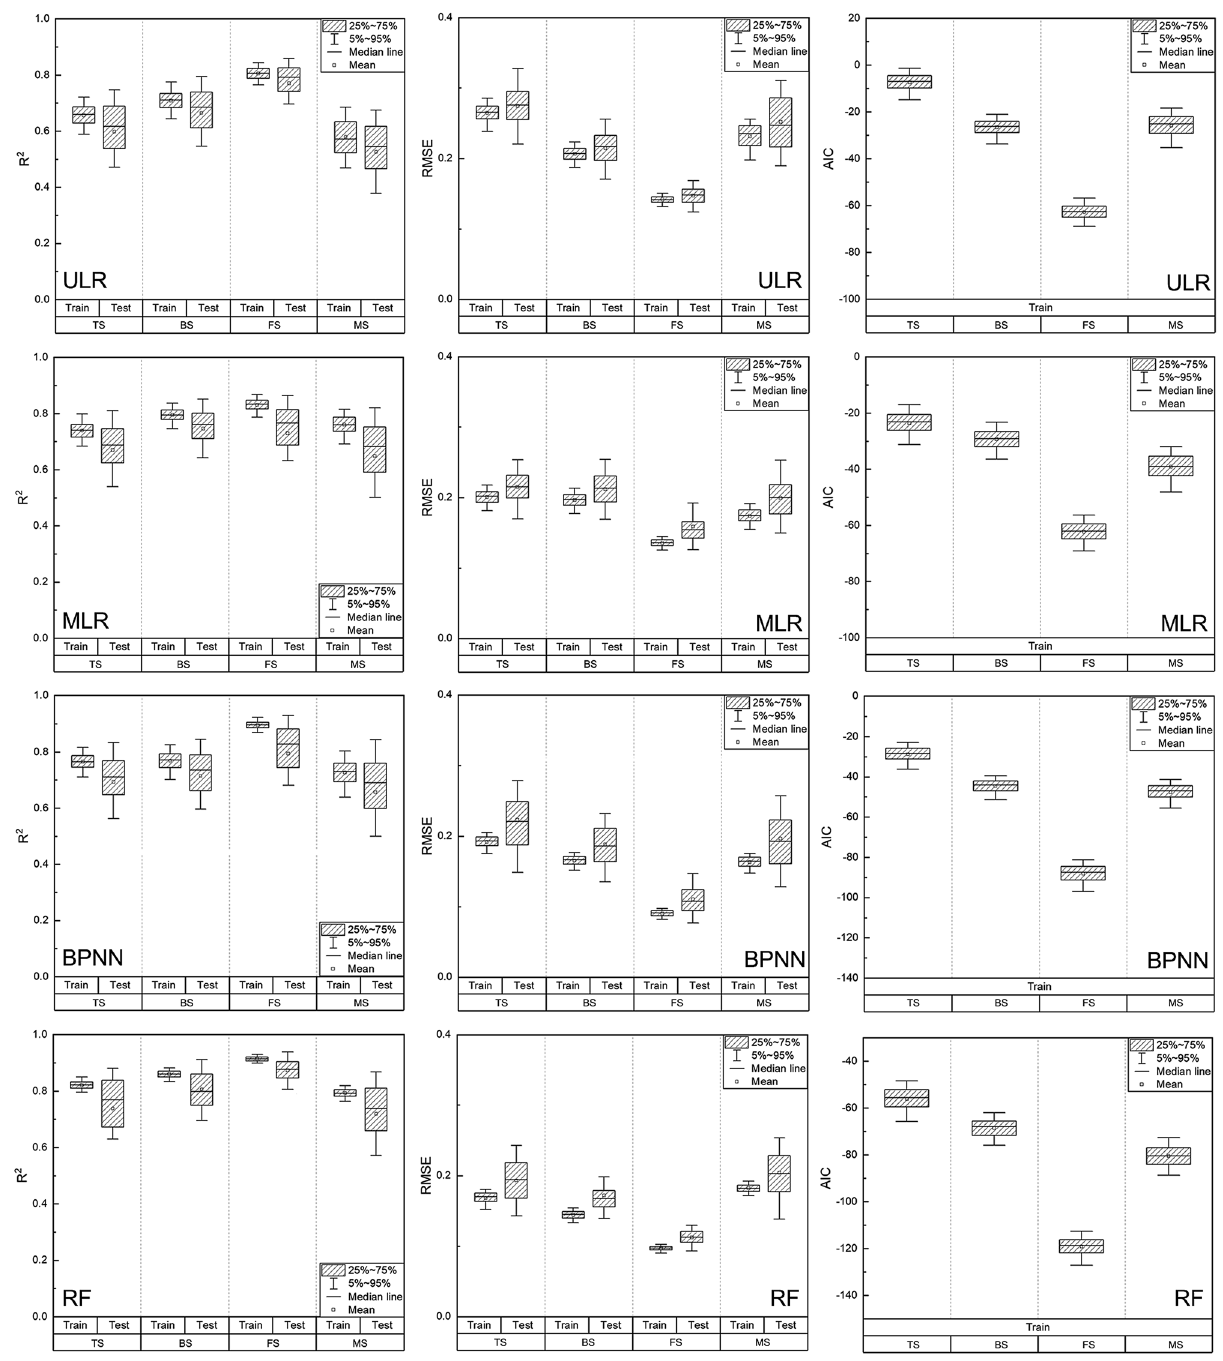
Figure 9. Performances of different regression models for LAI estimation at individual growth stages (Left. R 2 of different regression models. Middle. RMSE of different regression models. Right. AIC of different regression